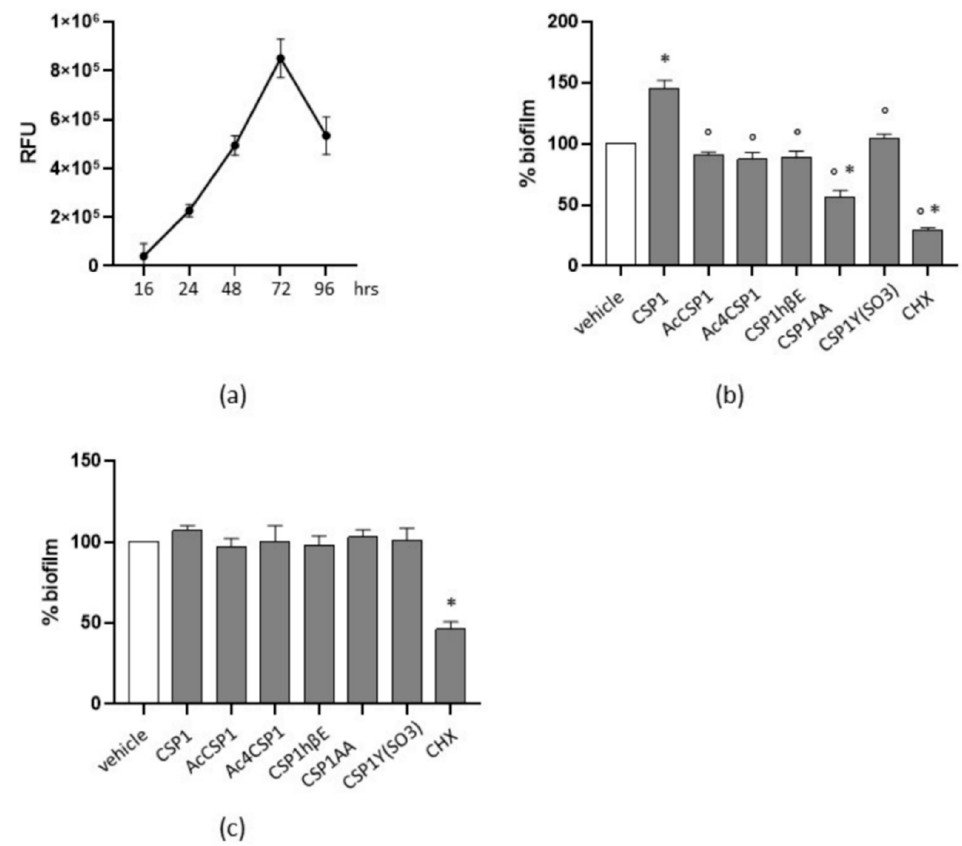
Figure 2. Peptides interfere in S. mutans biofilm formation. ( a ) Cultures of S. mutans were seeded in 96-well plates and incubated in 1:10 BHI:AS medium at 37 °C. Adhering cells were determined at